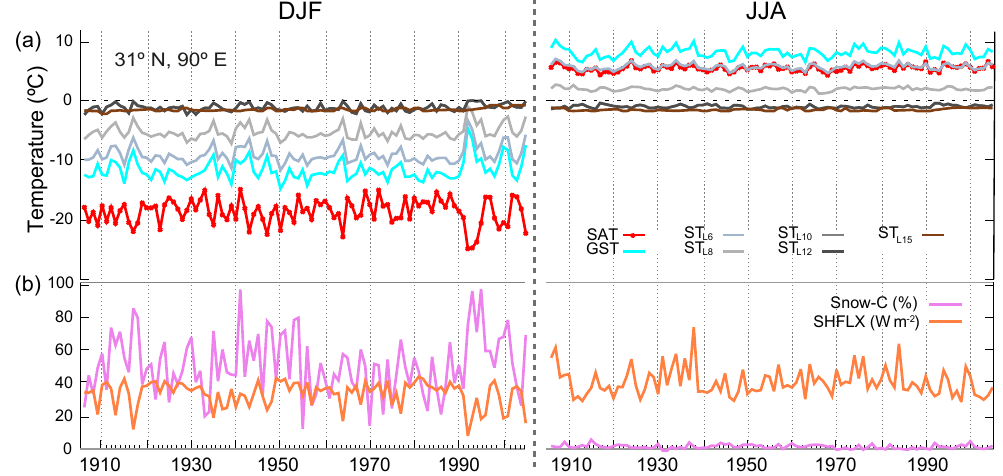
Figure 4. (a) DJF and JJA evolution of SAT, GST, ST L6 , ST L8 , ST L10 , ST L12 and ST L15 for a grid point from the ALL- F 2 simulation (Tibetan Plateau region; 31 ◦ N, 90 ◦ E) during the 1900–2005CE period. Dashed lines indicate 0 ◦ C. (b) Percentage of snow cover and surface sensible heat flux